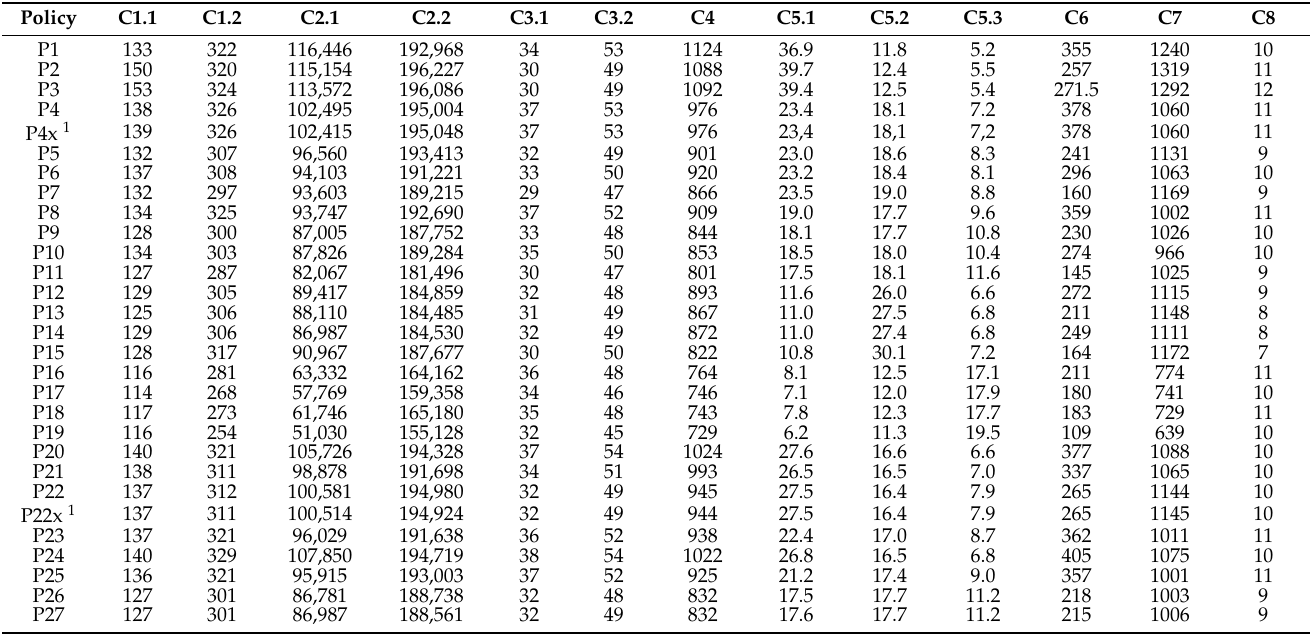
Table A3. Results—median values of all the criteria computed for all the alternatives assigned to a given policy. Policy